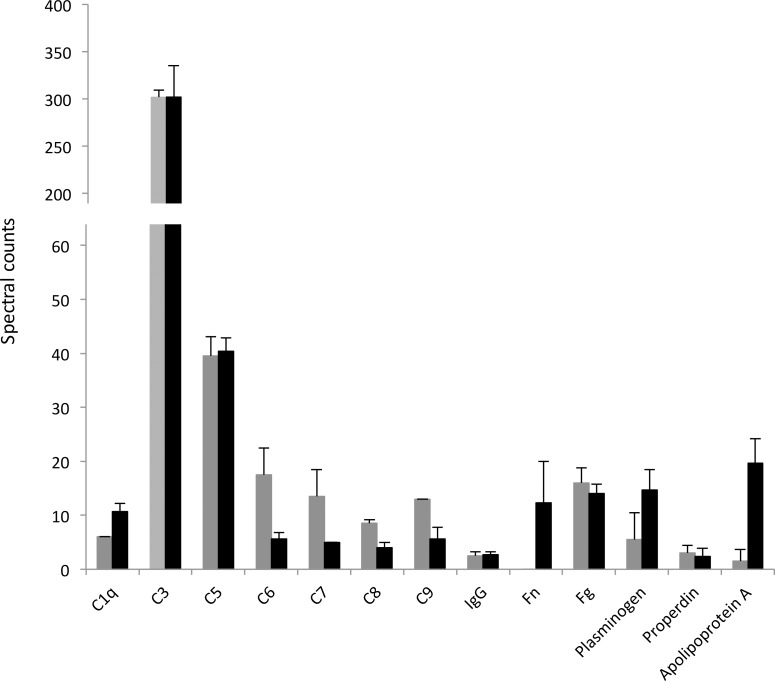
Mass spectrometry analysis of abundant plasma proteins deposited on C. acnes.C. acnes strains KPA171202 (black) and AS12 (gray) were grown in the presence of 2% plasma after which they were thoroughly washed, adherent proteins released by trypsin digestion, and analyzed using Shotgun mass spectrometry. Only the most abundant identified proteins are displayed and presented as means (± SD) from three biological replicates.